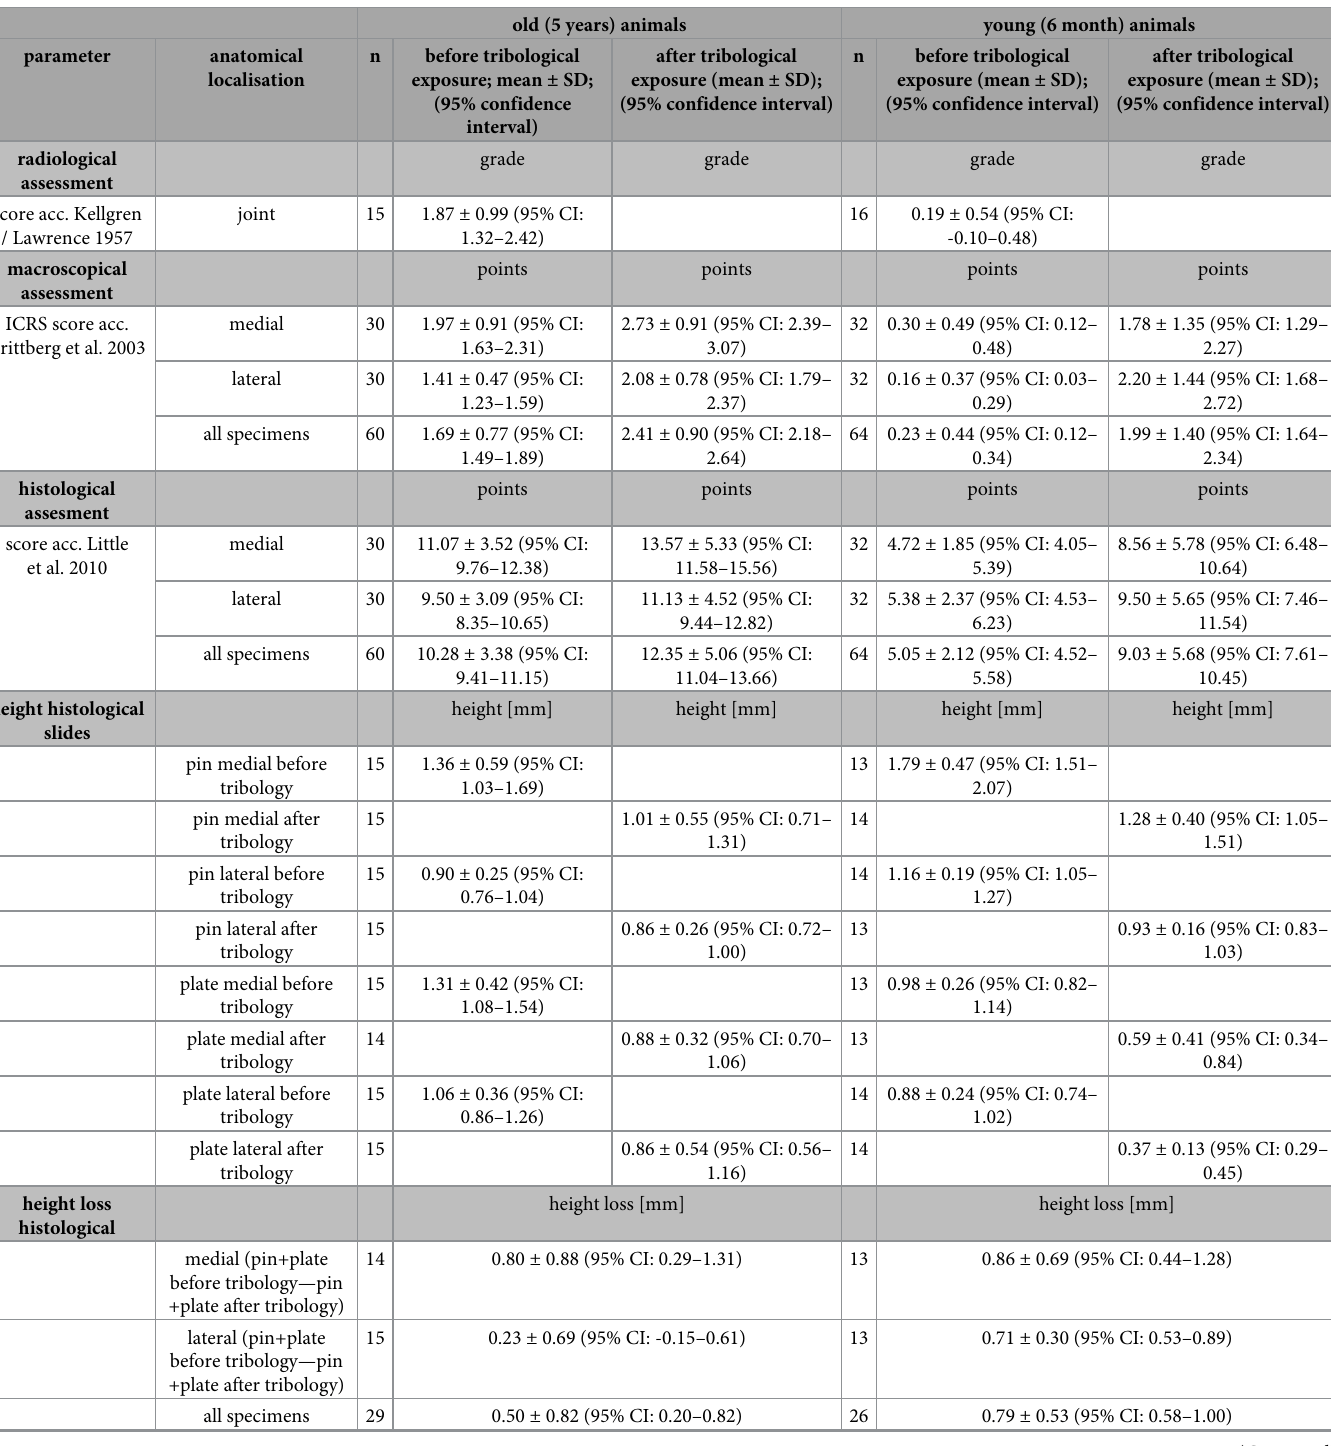
Table 2. The table provides a synopsis of the data of degenerative changes (points), heights and HL in the cartilage of the stifle joints from old and young pigs before and after tribological exposure and the friction forces. For the medial and lateral compartments of the stifle joints the HL was calculated using the tribometer and the histologically measured changes of the cartilage heights. The radiological assessments were only made on the complete joints before the tribological exposure. “n”specifies the number of assessed